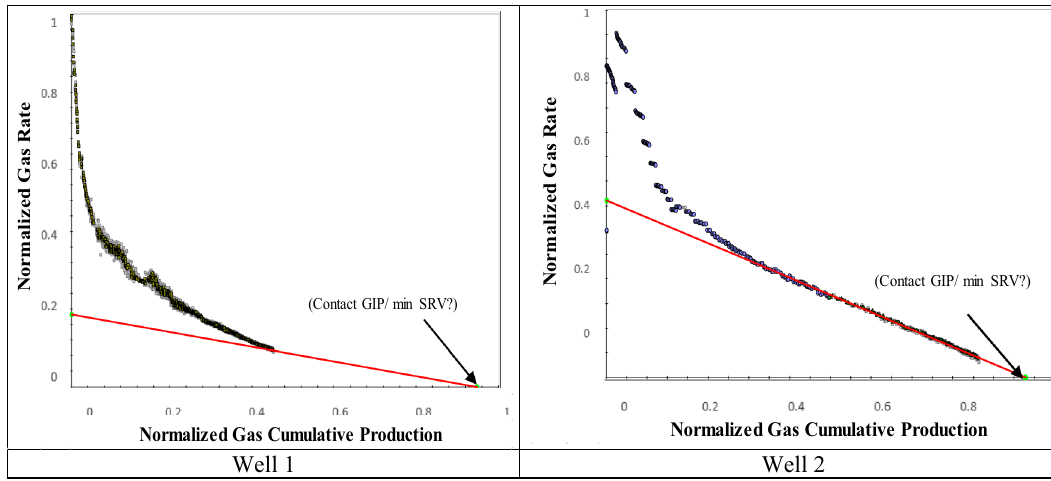
Fig. 5 Flowing material balance